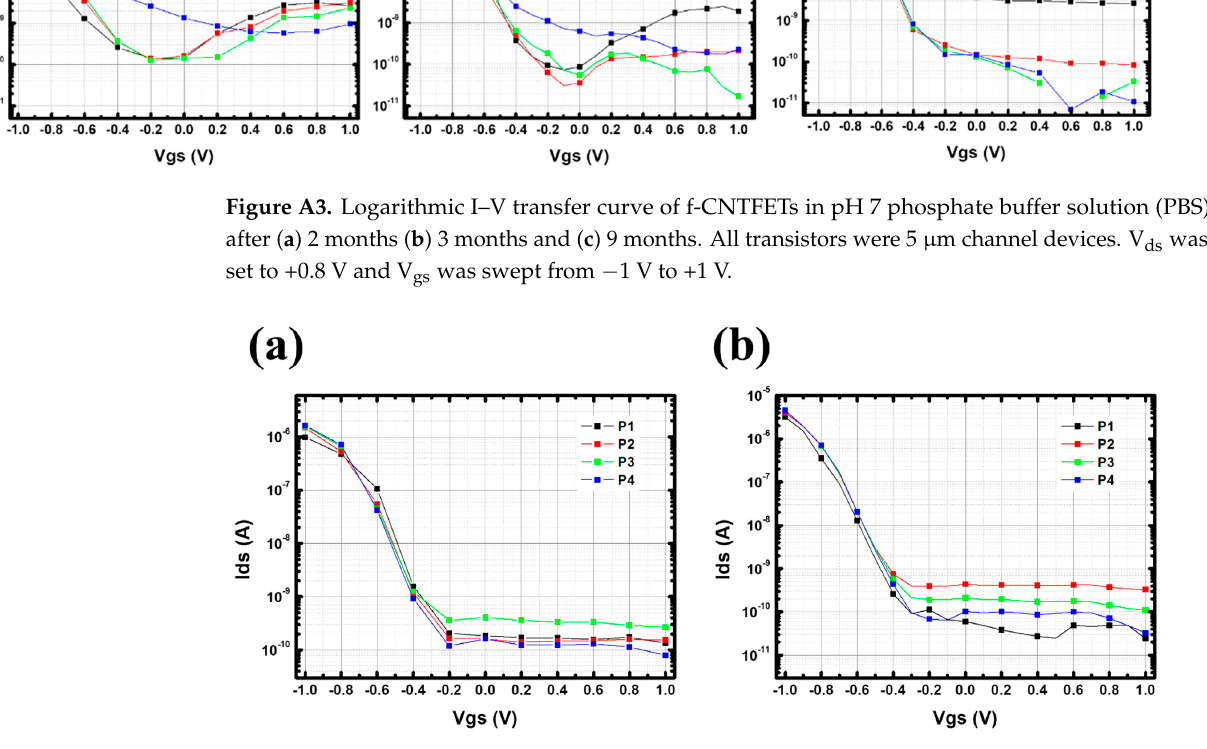
Figure A4. Logarithmic I–V transfer curve of p-CNTFETs in pH 7 phosphate buffer solution (PBS) after ( a ) two months and ( b ) three months. All transistors were 5 µm channel devices. V ds was set to +0.8 V and V gs was swept from − 1 V to +1 V.